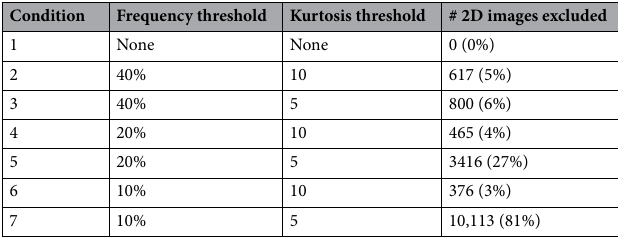
Table 2. Training data conditions and selection criteria.